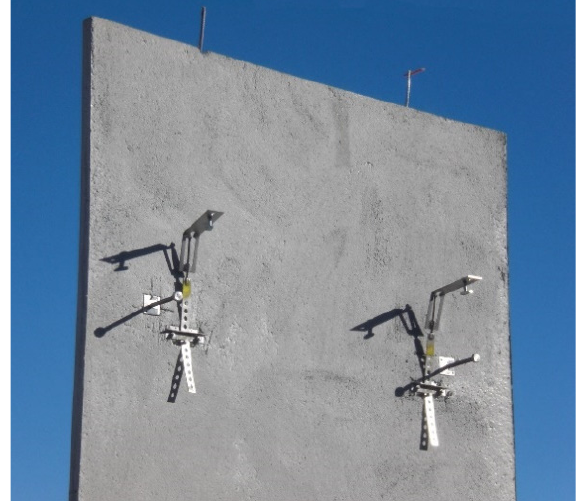
Figure 3. Storey-high façade element with new fix- ing system for carbon reinforced concrete.